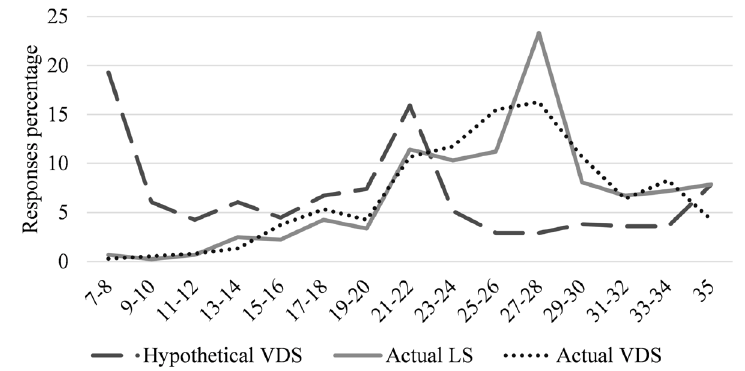
Figure 6. Comparison of actual score distributions of the post Likert-type scale (LS) and the post visual discrete scale (VDS) with hypothetical VDS if it were the expansion of the positive side of the Likert- type